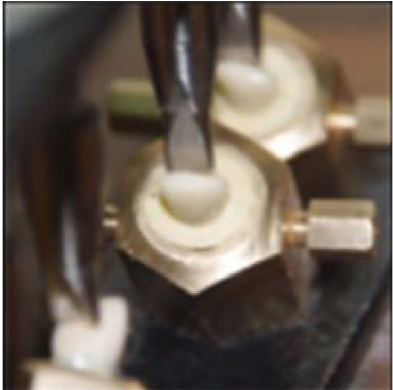
Figure 11: Loading stylus applying load onto the palatal surface of the crown 135 ° to the long axis of the tooth during the cyclic loading test.